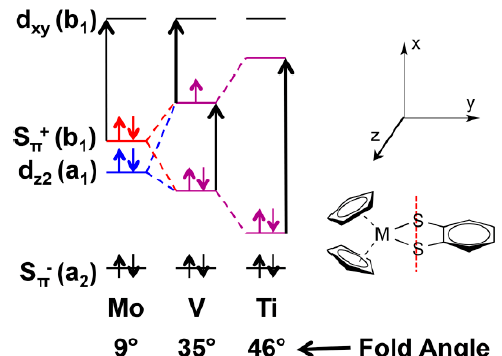
Figure 4. Fold angle distortions as a function of redox orbital electron occupancy in a series of Cp 2 M IV (bdt) complexes. (Adapted with permission from J. Am. Chem. Soc. 2018, 140, 14777–14788. Copyright (2018) American Chemical Society).